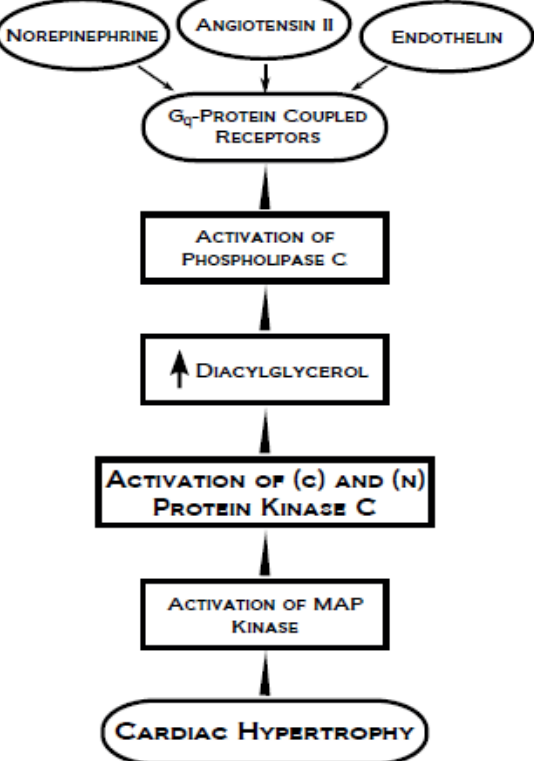
Figure 5. Signal transduction mechanisms involving the activation of conventional (c) and novel (n) protein kinase C and MAP kinase for the development of cardiac